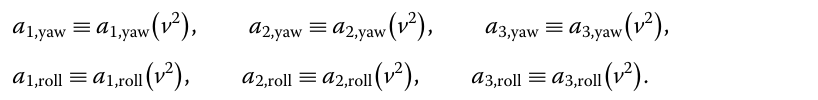
of the kinetic energy-like